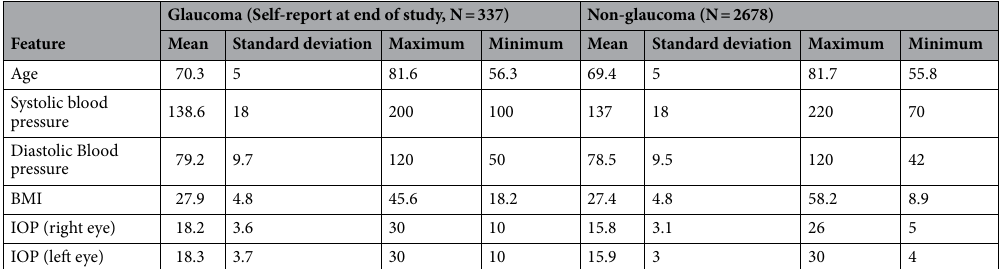
Table 2. Statistical summary of the numerical features of the subjects at the time of enrollment.